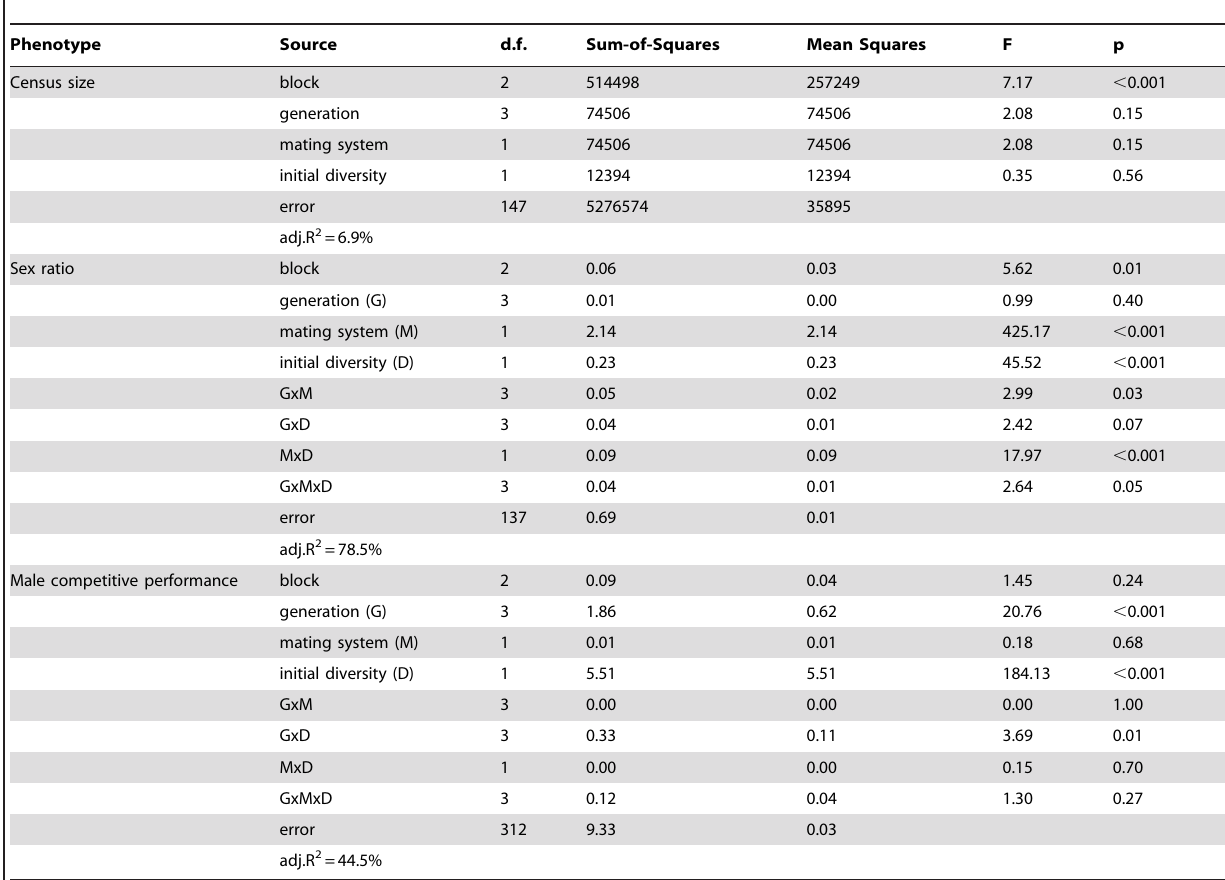
Table 1. ANOVA of census size, sex ratio and male competitive